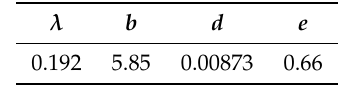
Table 1. Simulation